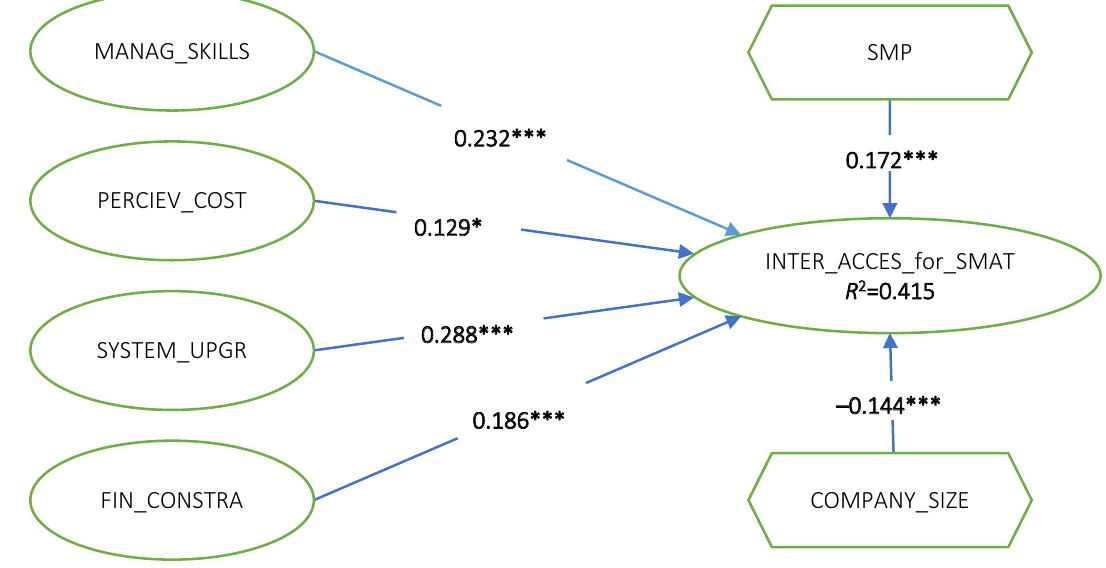
Figure 2. Estimated model from ADANCO 2.0 version